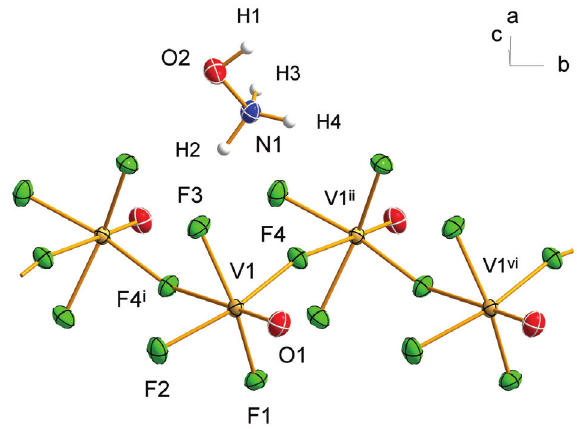
Figure 1. The asymmetric unit is composed of a (NH and a VOF -unit which has been expanded to reveal a zigzag 4 [ VOF ] n – chain anion comprised of cis -corner sharing [ VOF 4 n octahedra. Thermal ellipsoids are drawn at the 70% probability level and hydrogen atoms are depicted as small spheres of arbitrary